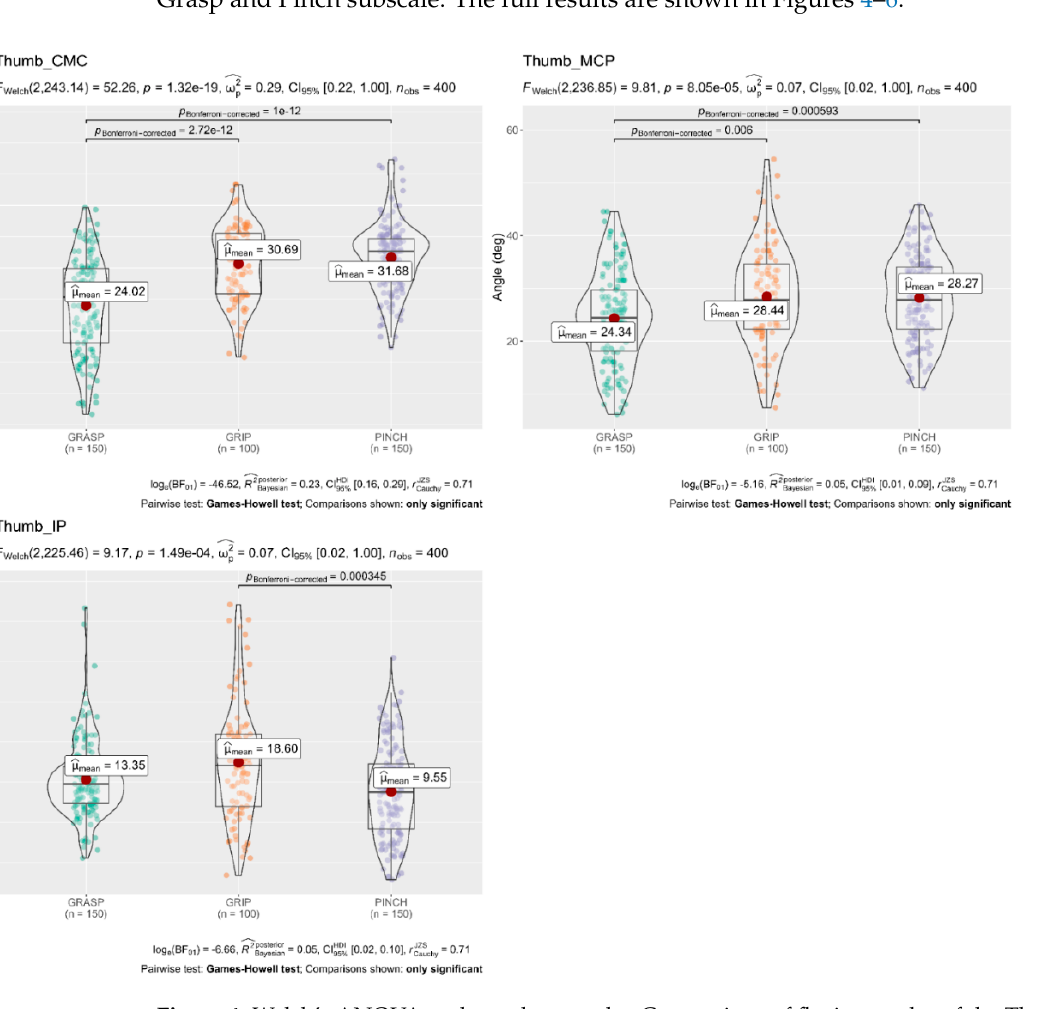
Figure 4. Welch’s ANOVA and post hoc results; Comparison of flexion angles of the Thumb joints concerning the three Subscales of the ARAT. The flexion angles of the carpometacarpal (CMC) and metacarpophalangeal (MCP) joints of the Thumb finger were significantly larger ( p < 0.05 each) in